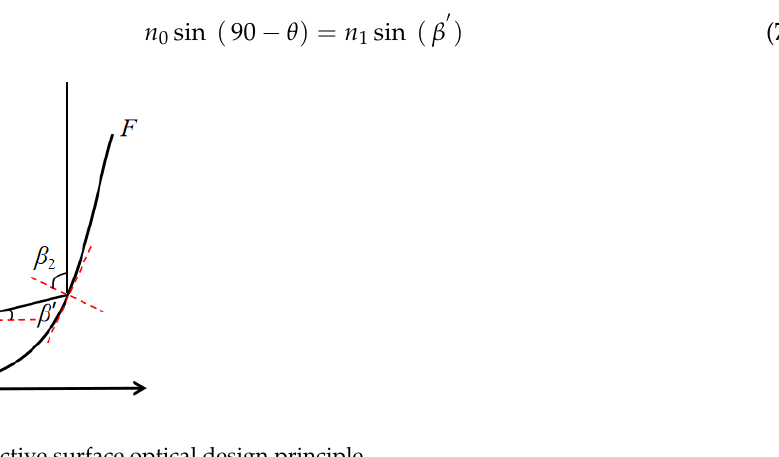
Figure 7. Side reflective surface optical design principle.